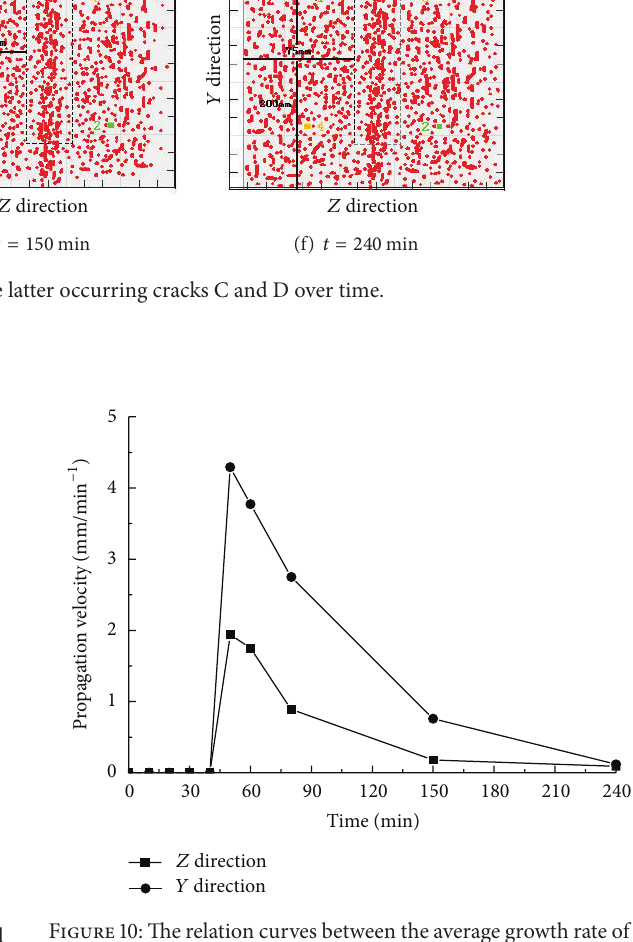
Figure 9: The relation curves between the growth lengths of C and D and time.